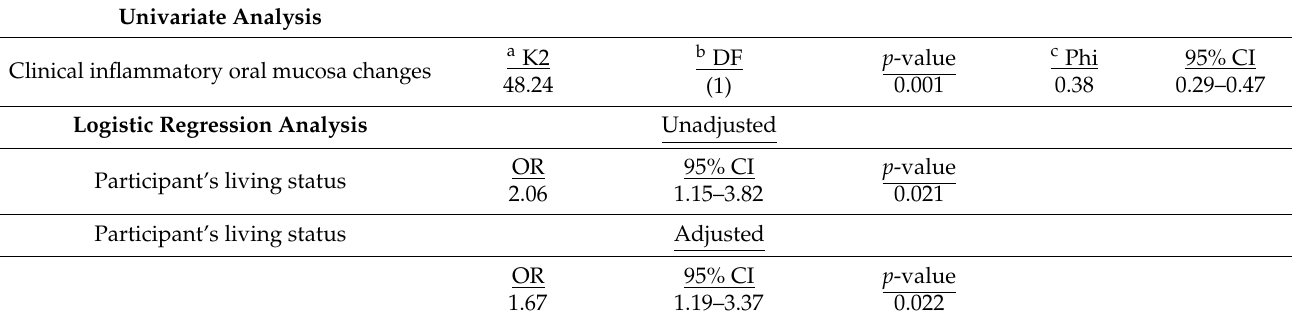
Table 6. Statistical analysis—oral cancerous/precancerous lesions associations.